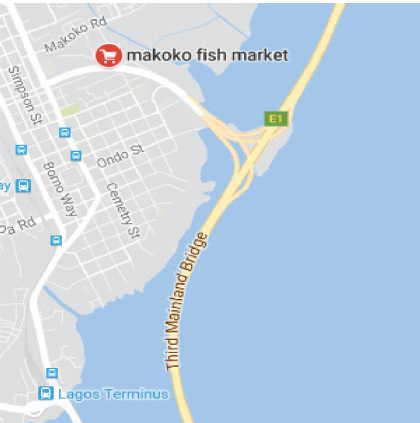
Figure 1: Makoko river map showing site of sampling (Makoko fish